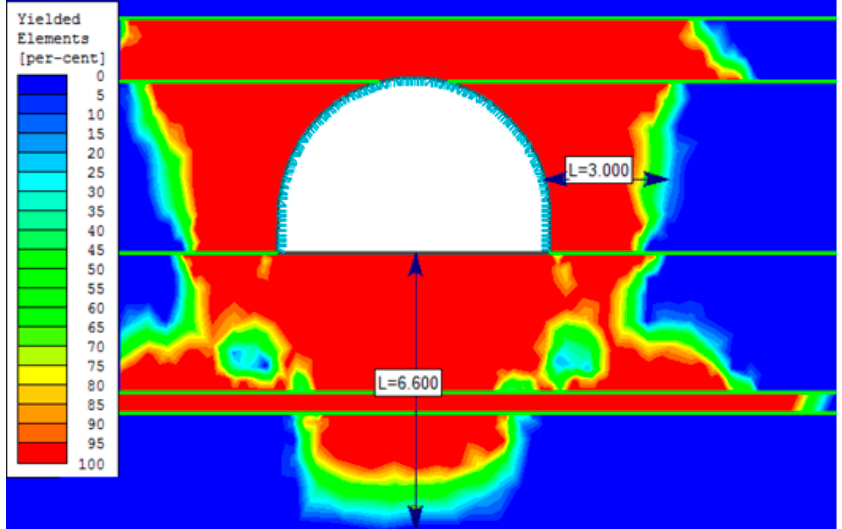
Figure 10. Model no. 1—elasto plastic—yielded rock mass elements.